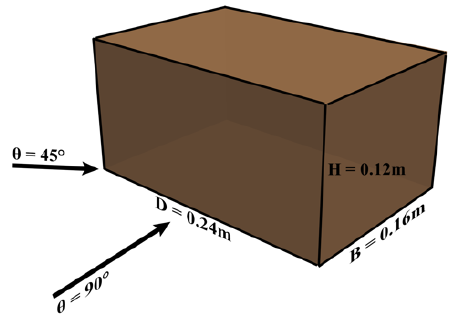
Figure 1. Geometry of the low-rise building and attack